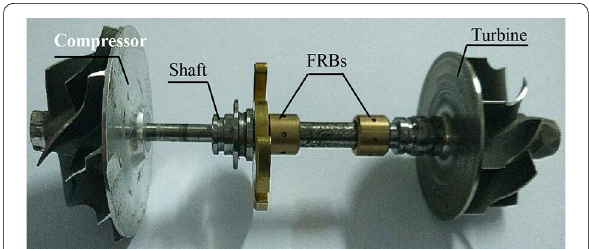
Figure 1 Automotive TC rotor supported with